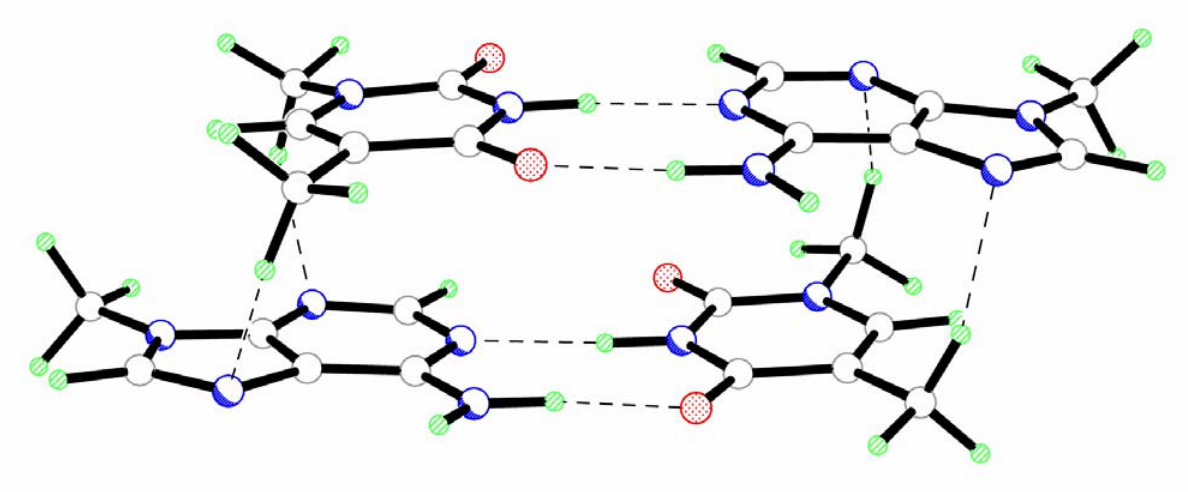
Figure 2. Geometry of the head-to-tail isomer of a stacked dimer of the AT pairs